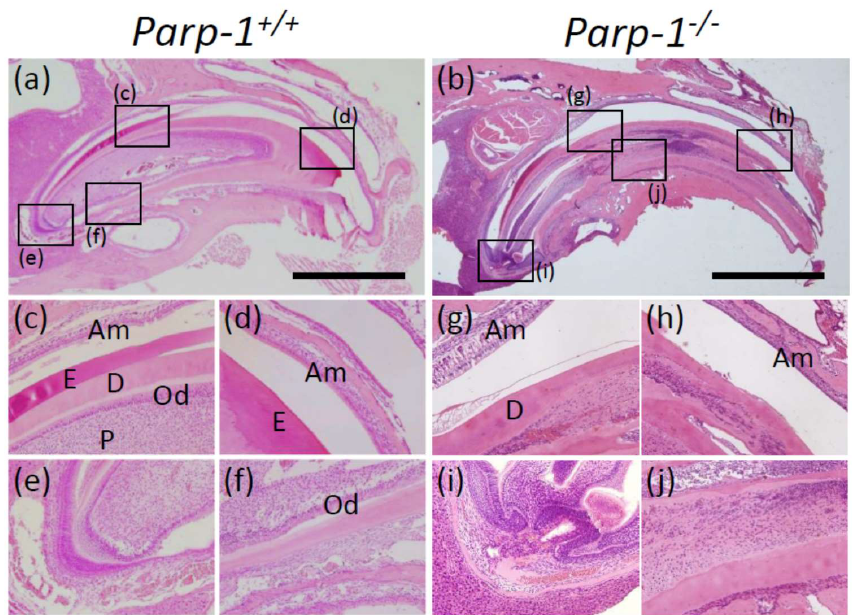
Figure 2. Histopathological analysis of incisors of aged Parp-1 +/+ and Parp-1 −/− mice (C57BL/6). HE staining of sagittal plane of Parp-1 +/+ ( a ) and Parp-1 −/− incisors ( b ). ( c–f ): A higher magnification of Parp-1 +/+ incisor showing the distinct structure of normal tooth. On the other hand, a higher magnification of the Parp-1 −/− incisor showed almost normal ameloblast layers 1/3 from the apex ( g ), however, it turned to layers of shrunken ameloblast at the incisor edge ( h ). Odontoblasts of the Parp-1 −/− incisor were almost normal in the apex area ( i ) and they also turned to shrunken cells and moreover, the layer itself disappeared ( j ). Am, ameloblast; Od, odontoblast; E, enamel; D, dentin; P, pulp. Bars indicate 2